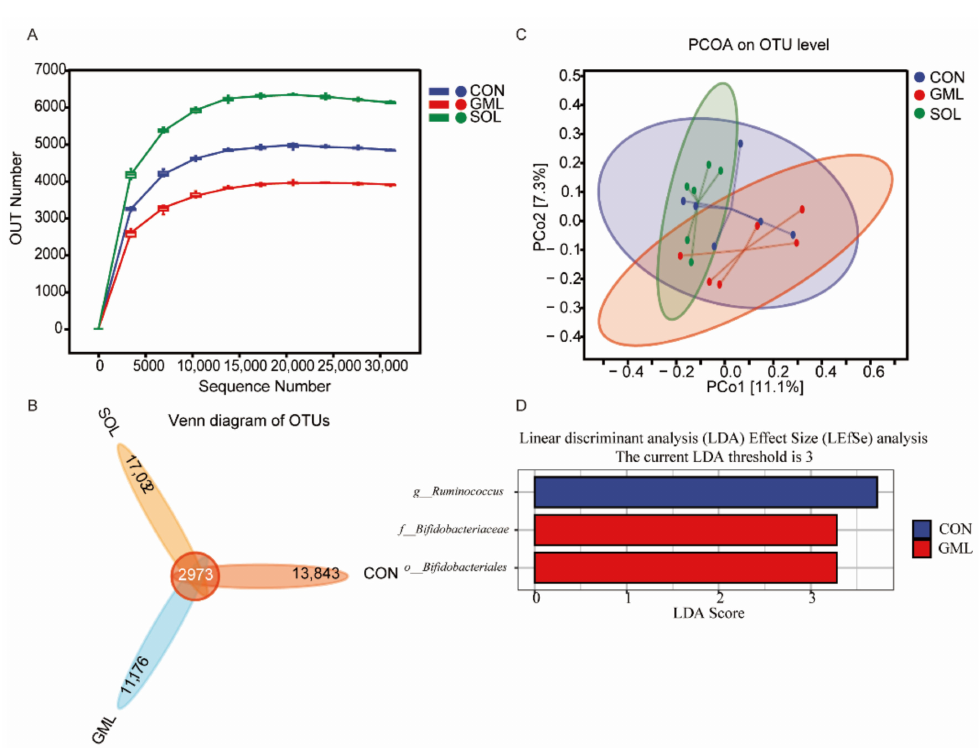
Figure 1. Effects of monoglyceride laurate and Solider on the rumen bacterial diversity of weaned lambs. ( A ) The rarefaction curve of sequencing based on the OTUs. OTUs, operational taxonomic units; ( B ) Venn diagram of the OTUs in the three treatment groups. OTUs, operational taxonomic units; ( C ) Principal components analysis (PCoA) of the rumen bacterial flora. The PCoA was based on the unweighted UniFrac distances between the microbiome profiles; ( D ) Linear discriminant analysis (LDA) effect size (LefSE) analyses-identified rumen bacterial biomarkers of different groups (LDA > 3, FDR <